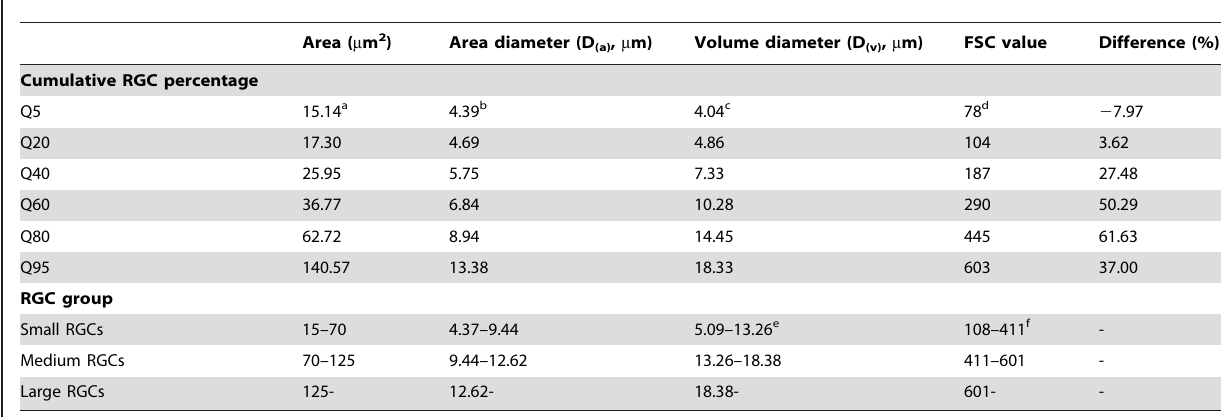
Table 2. Deviations of RGC size percentiles determined by flatmount and flow